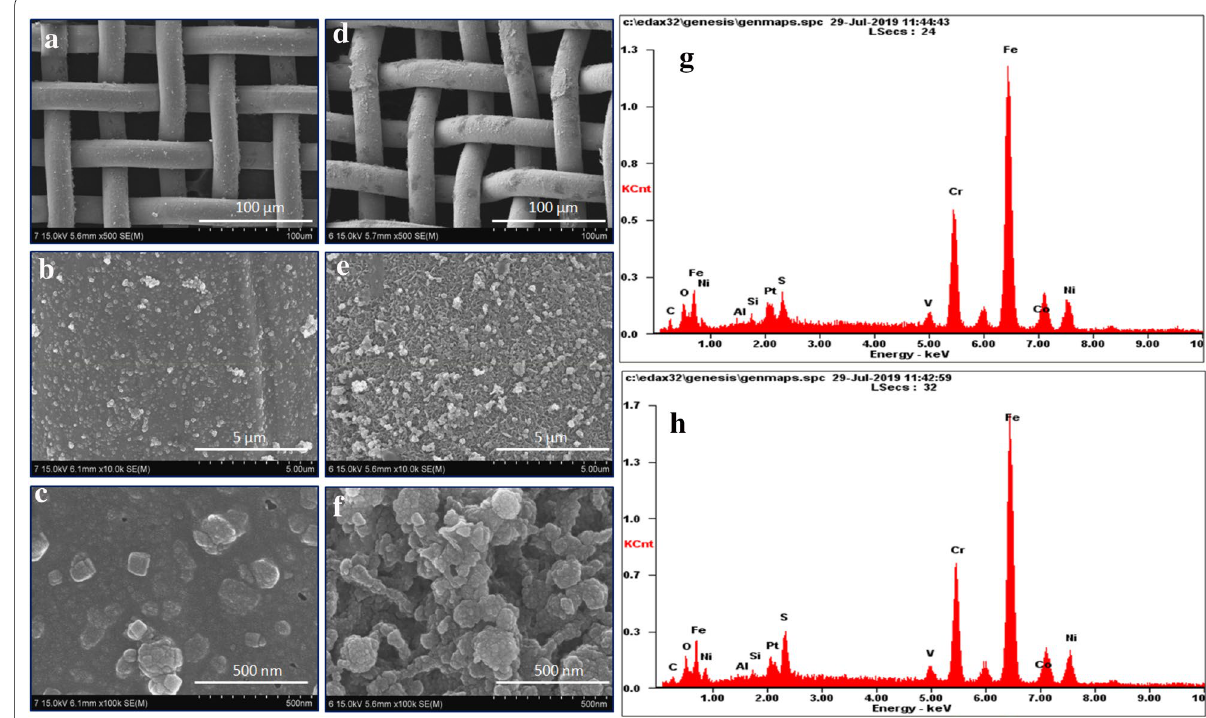
Fig. 2 The low and high‑magnified SEM images of VS 2 on a – c non‑etched and d – f 1% etched SSM substrate. The EDS spectrum of VS 2 on the g non‑etched and h 1% etched SSM